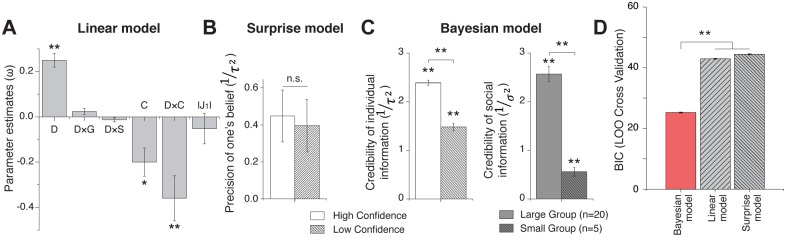
Model comparisons of the predictability of the changes in judgments.(A) Parameter estimates in the “linear model” indicating that participants assign a significant weight to the differences in judgments (D), their confidence level (C), and the interaction between them (D × C), but not to the interaction with group size (D × G) and scenario types (D × S) (Eq 7). Error bars represent the standard error of the mean (SEM). (B) The “surprise model” hypothesized that participants who have greater confidence in their judgments are more likely to be surprised by unexpected differences in judgments with a social group and to adapt their judgments to the given judgments of groups. However, the parameter estimates in this model suggest that the different level of confidence could not explain the different level of judgment adaptation (Eq 8). (C) The “Bayesian model” (Eq 6) provides 2 individual, specific functions that allow us to track the changes in credibility. First, individual jurors were more likely to assign credibility to their individual information (J1) when they had a higher level of confidence (left panel). Second, participants assigned more credibility on social information (JS) when it was provided by a larger (n = 20) compared to a smaller (n = 5) group (**, P < 0.001; right panel). (D) The likelihoods of each model prediction were estimated by a leave-one-out-cross-validation (LOOCV) procedure, and the Bayesian information criteria (BIC) were compared between models. The BIC showed that predicted changes in judgments of the “Bayesian model” fit better to the actual changes in judgments than the other models (**, P < 0.001). The data underlying this figure can be found in S1 Data.